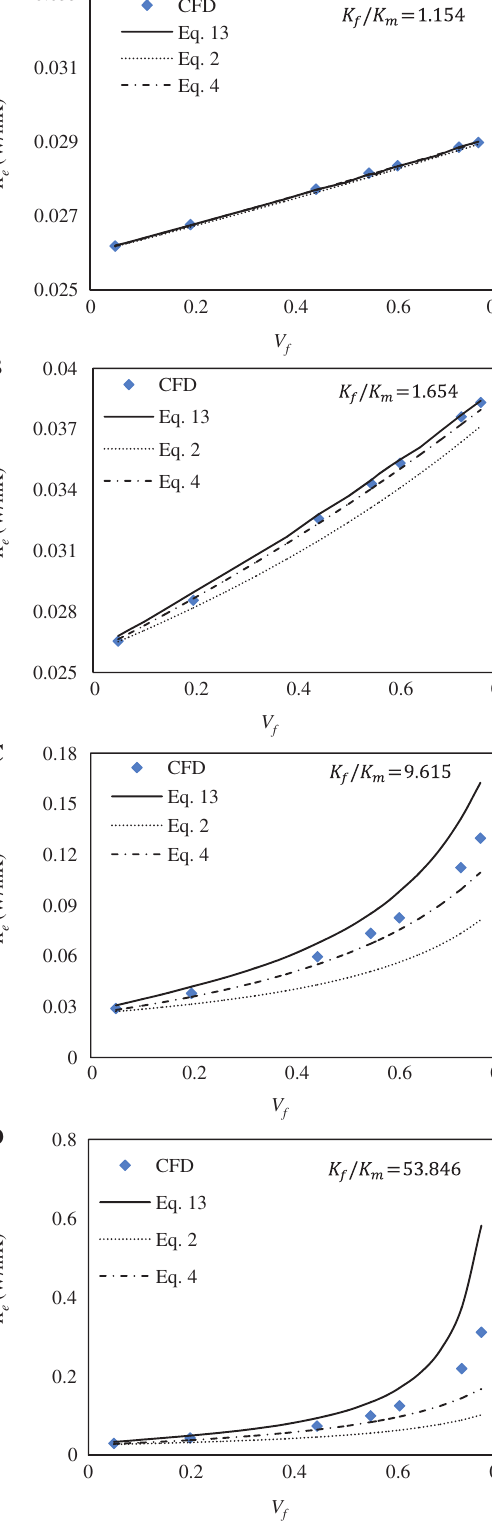
values: (A) cotton/air, f